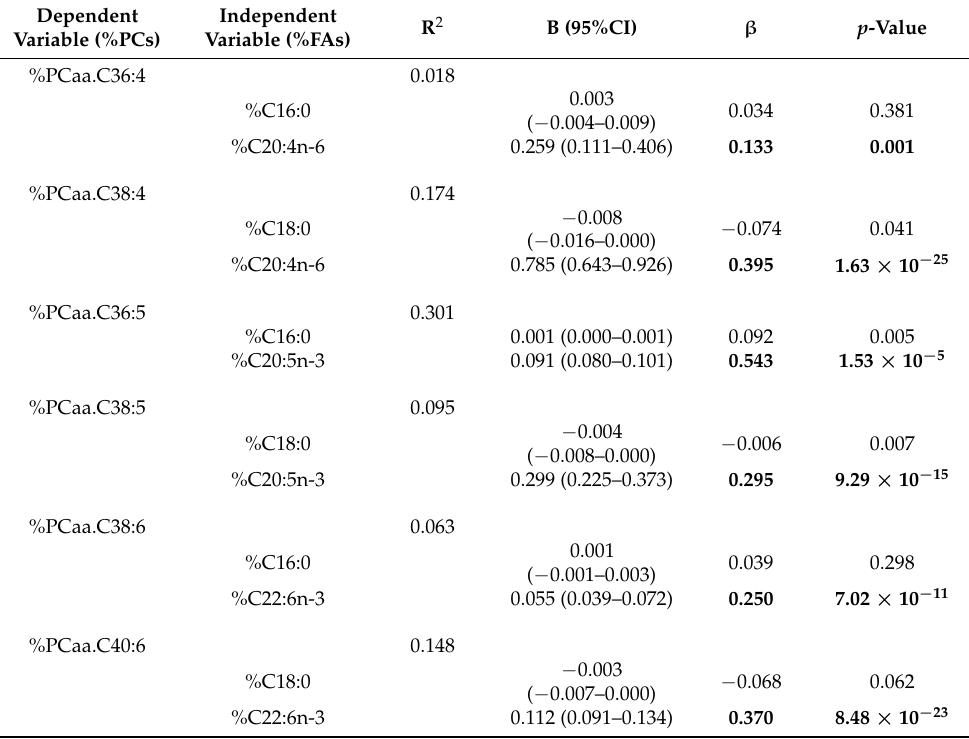
Table 5. Multiple linear regression analysis relating LCPUFA-containing PC species percentages to total FA